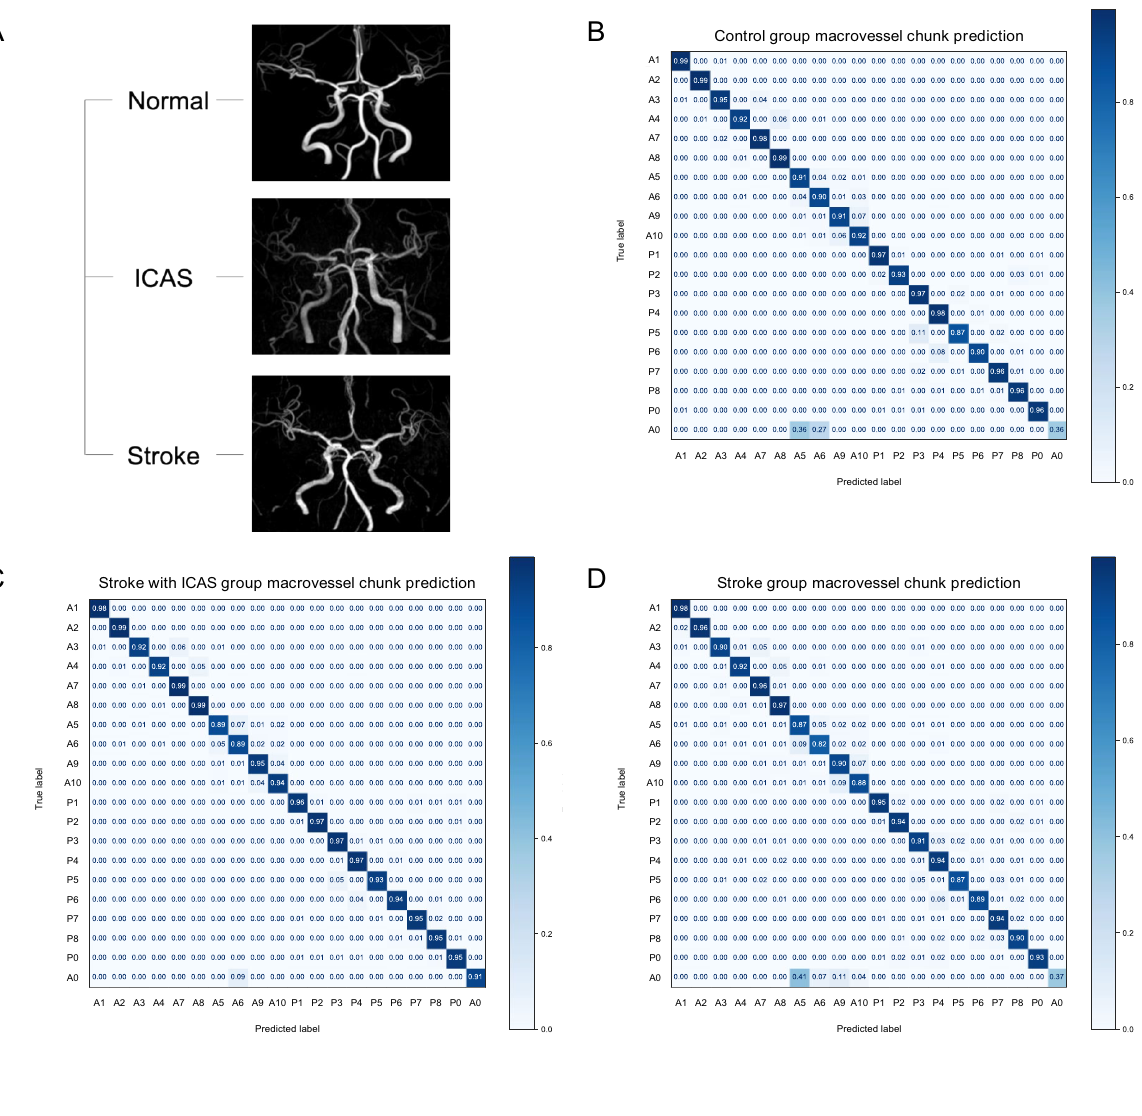
Figure 2. Prediction performance profiles of a 20-chunk macrovessel in the control, ICAS, and stroke group cohorts. ( A ) Examples of 3D cerebrovascular models of the disease-free healthy subjects, stroke-only patients, and stroke-with-ICAS patients. Macrovessel chunk prediction results of ( B ) control cohorts, ( C ) ICAS cohorts, and ( D ) stroke cohorts are shown. A0, anterior communicating artery; A1, branches of the right internal carotid arteries; A2, branches of the left internal carotid arteries; A3, basal branches of the right middle cerebral artery; A4, basal branches of the left middle cerebral artery; A5, basal branches of the right anterior cerebral artery; A6, basal branches of the left anterior cerebral artery; A7, pial branches of the right middle cerebral artery; A8, pial branches of the left middle cerebral artery; A9, pial branches of the right anterior cerebral artery; A10, pial branches of the left anterior cerebral artery; P0, basilar artery; P1, branches of the right vertebral artery; P2, branches of the left vertebral artery; P3, basal branches of the right posterior cerebral artery; P4, basal branches of the left posterior cerebral artery; P5, pial branches of the right posterior cerebral artery; P6, pial branches of the right posterior cerebral artery; P7, branches of the right superior cerebellar artery, anterior inferior cerebellar artery, and posterior inferior cerebellar artery; P8, branches of the left superior cerebellar artery, anterior inferior cerebellar artery, and posterior inferior cerebellar